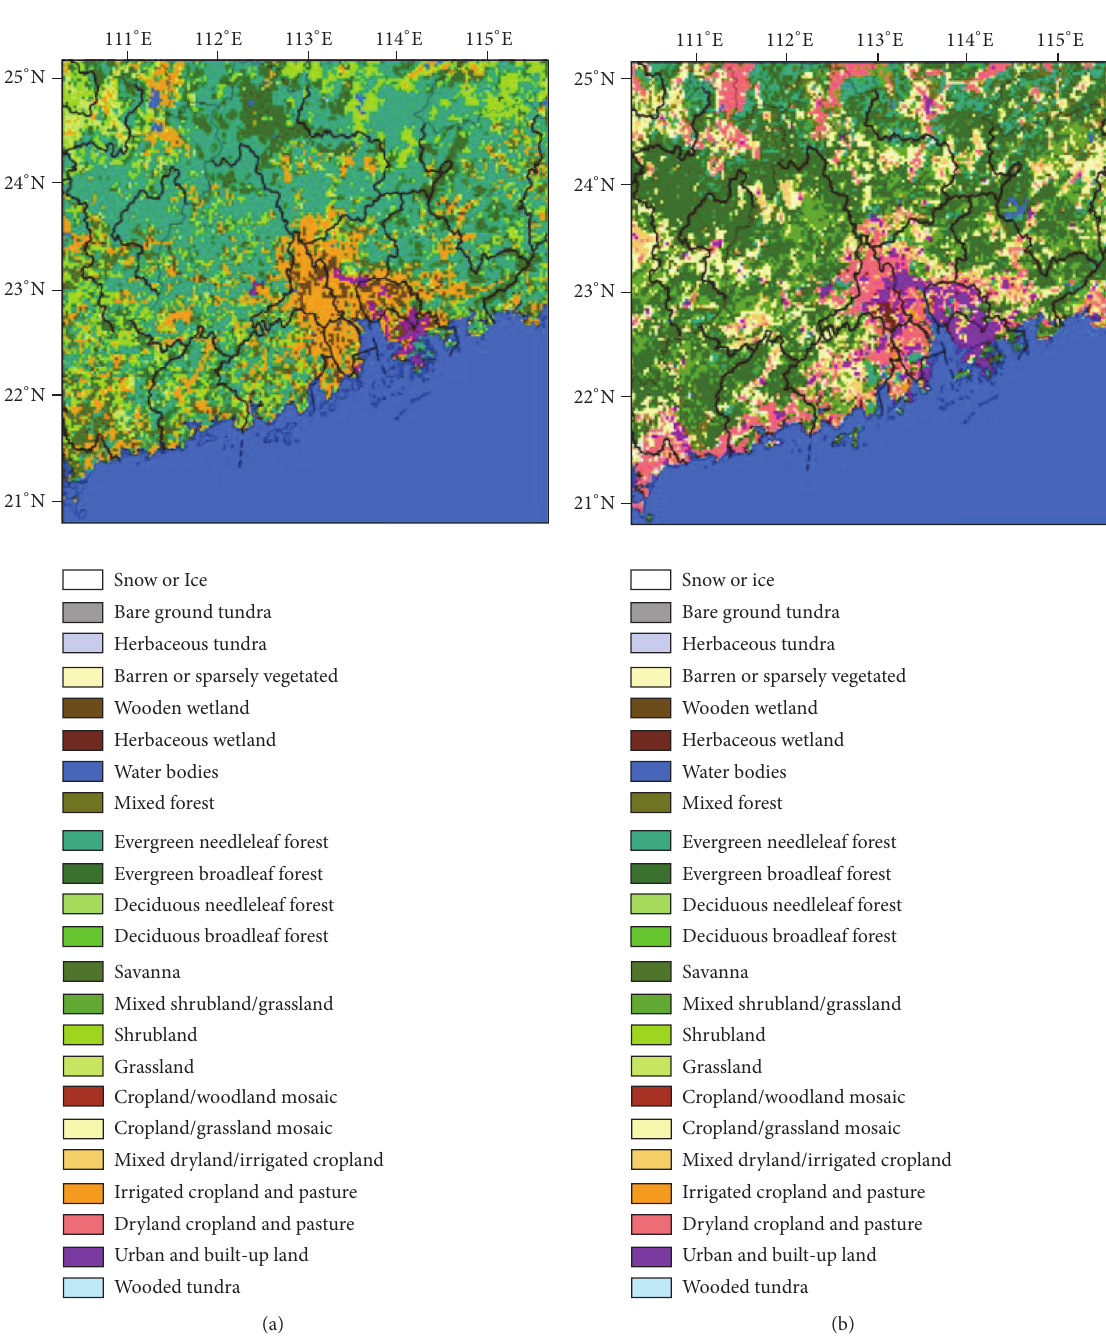
Agency (ESA), are processed by the same GlobCover system, and followed the same classification module. Both of